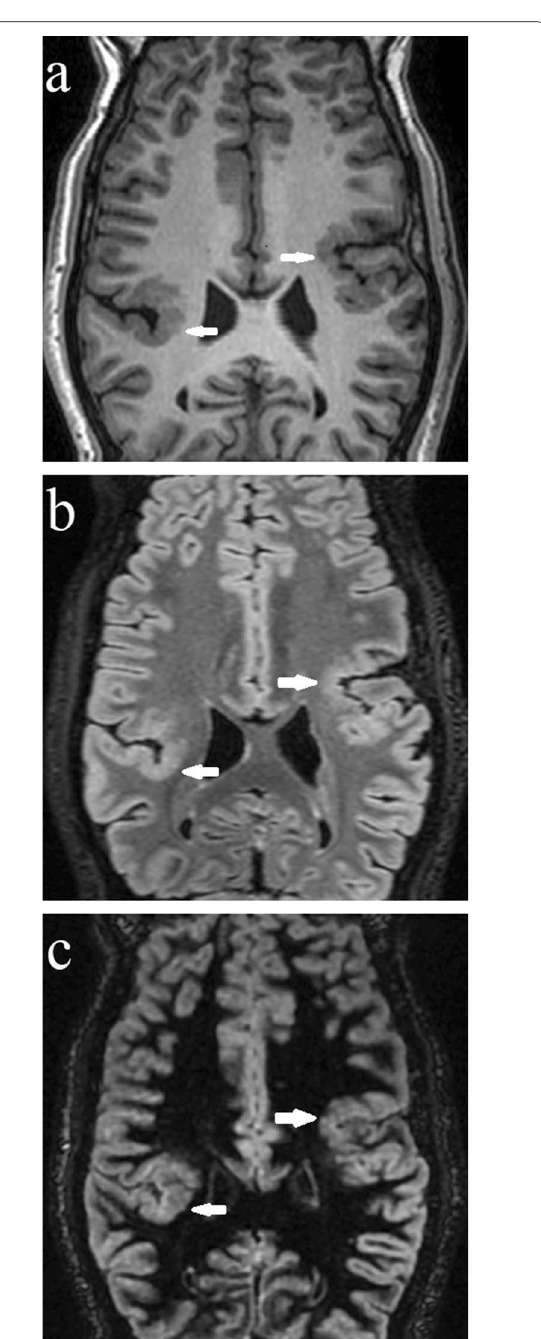
Fig. 3 Bilateral peri-Sylvian polymicrogyria in an 18 years old female patient. Reconstituted curved axial T1 ( a ), FLAIR ( b ) and DIR ( c ) images. Bilateral peri-Sylvian areas of abnormal gyral pattern with irregular convoluted thick cortices noted (arrows in a – c ). No signal intensity difference between the normal and abnormal cortex on any of the pulse sequences, including